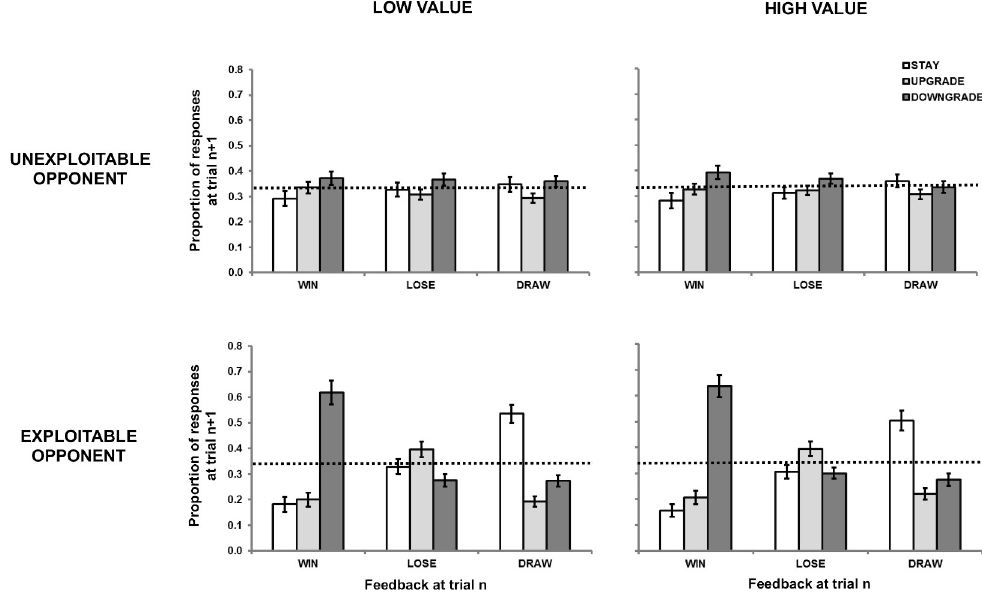
Fig 1. Proportion response data from Experiment 1 in terms of the relationships between the outcome at trial n ( win , lose , draw ) and the strategy selected at trial n+1 ( stay , downgrade , upgrade ). Participants competed against four opponents defined by the factors of value ( low , high ) and exploitability ( unexploitable , exploitable ). Error bars represent standard